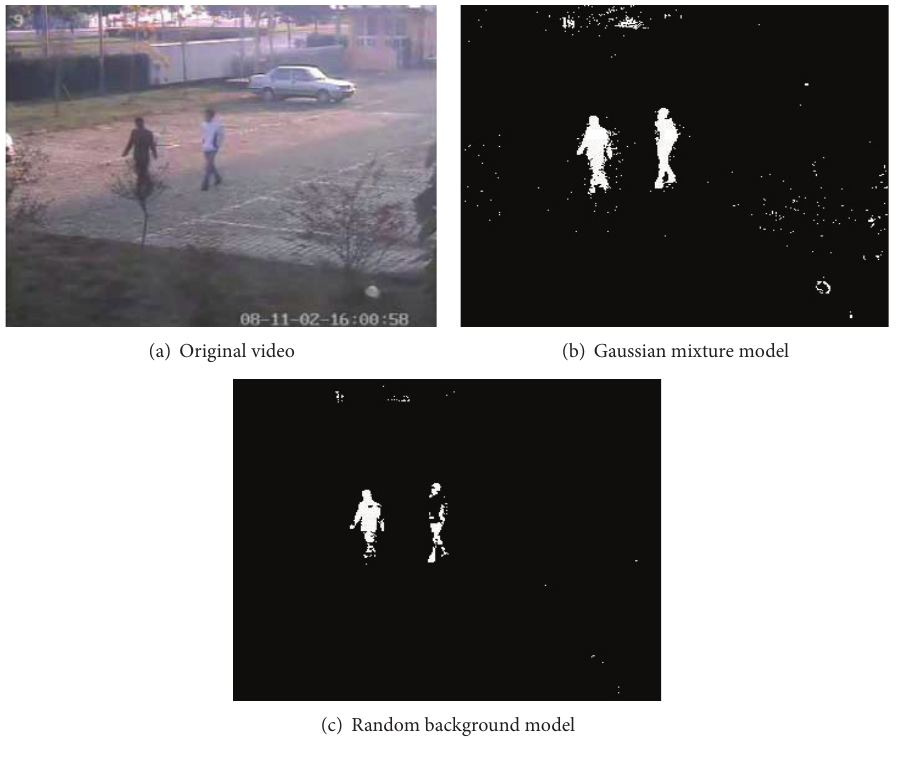
Figure 3: The target detection results of video data